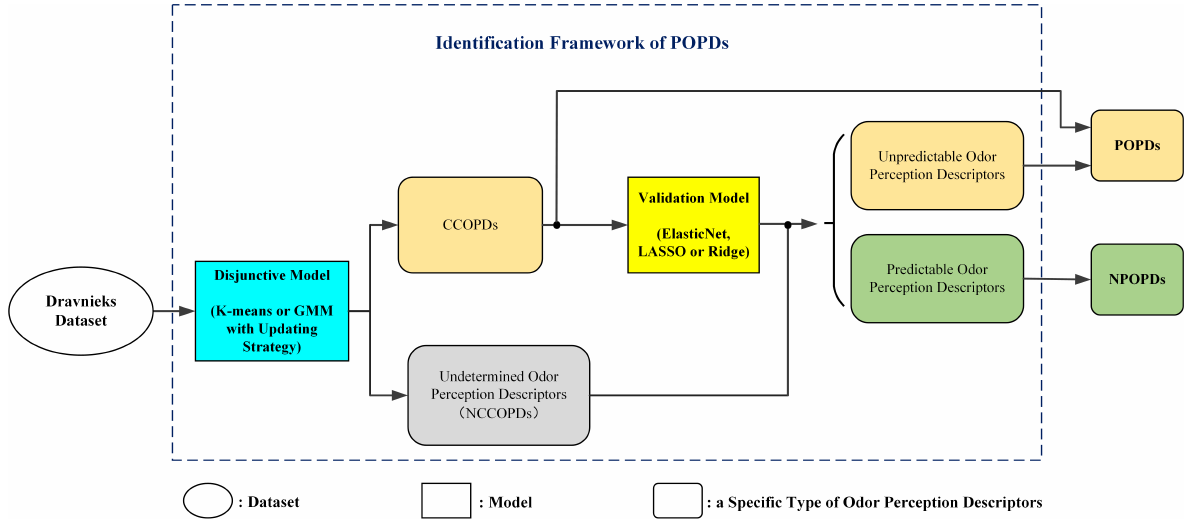
Figure 1. The identification framework of primary odor perceptual descriptors (POPDs). It comprises the disjunctive model and the validation model. The disjunctive model is implemented to separate the Clustering-Center Odor Perception Descriptors (CCOPDs) and Non-Clustering-Center Odor Perception Descriptor (NCCOPDs). The NCCOPDs are the undetermined descriptors. The validation model is applied to divide the undetermined descriptors into predictable and unpredictable odor perception descriptors. The CCOPDs and unpredictable odor perception descriptors are identified as the POPDs, and the predictable odor perception descriptors as the